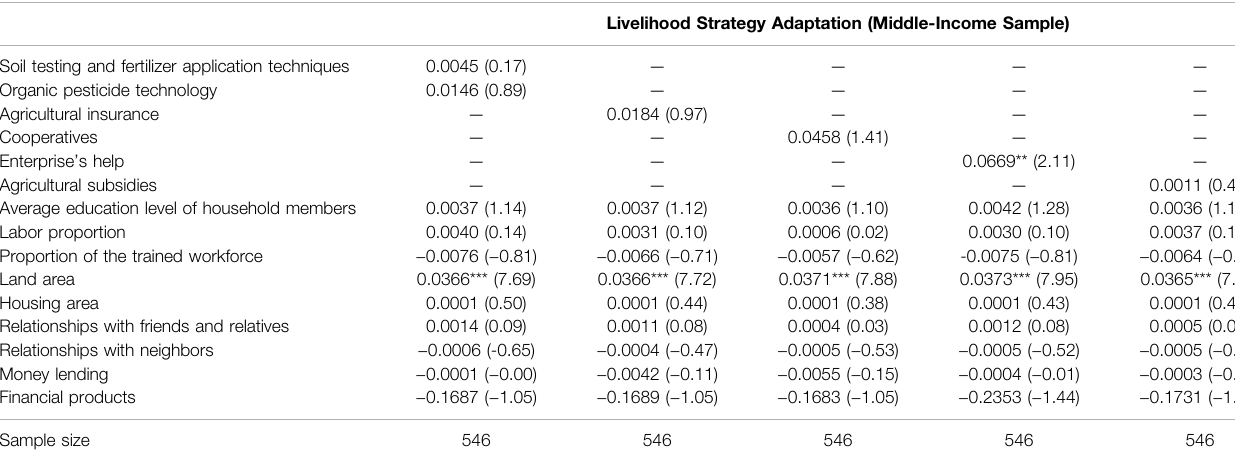
TABLE 6 | Regression results for the middle-income